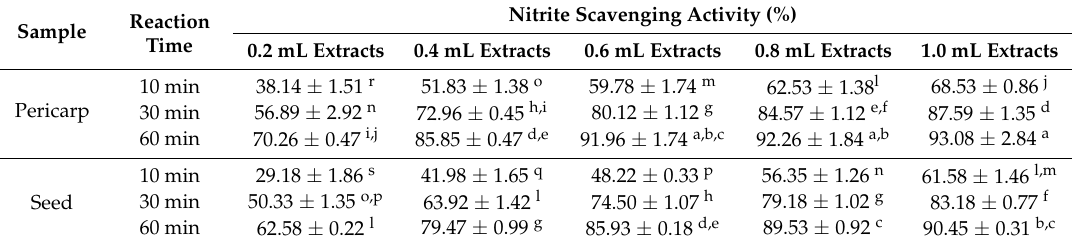
Table 6. Nitrite scavenging activities of alkaloid extracts from longan